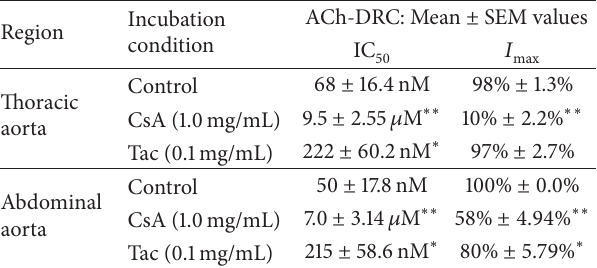
Table 1: The comparative effects of in vitro incubation with two calcineurin inhibitors (CNI), cyclosporine (CsA, 1.0mg/mL), or tacrolimus (Tac, 0.1mg/mL) for 30 min duration on acetylcholine (ACh)-induced vasodilator responses in phenylephrine (PE, 1 𝜇 M)- constricted thoracic and abdominal rat aortic rings with intact endothelium.